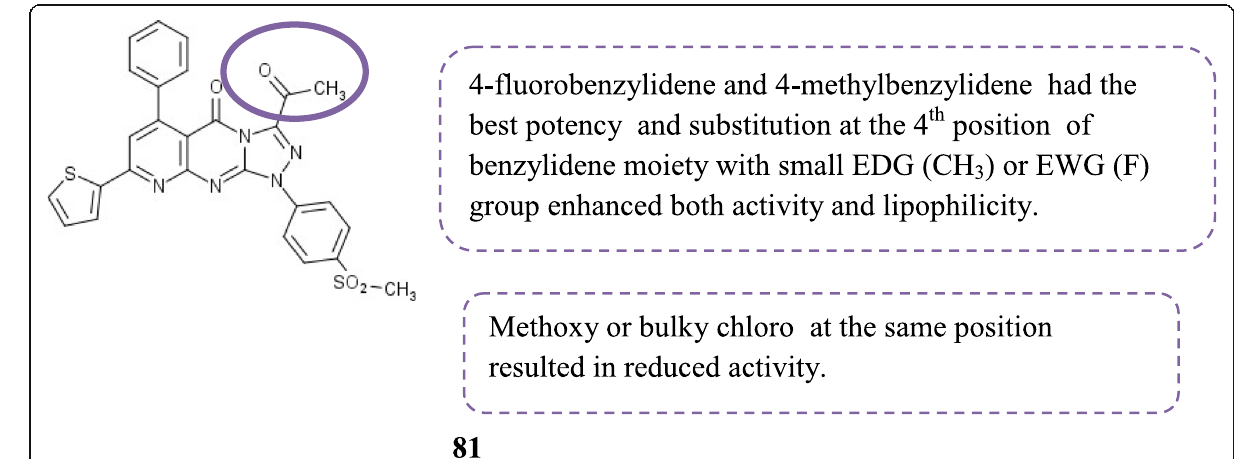
Fig. 27 SAR studies and chemical structures of pyrido[2,3-d] [1,2,4]triazolo[4,3-a]pyrimidine derivatives and pyrido